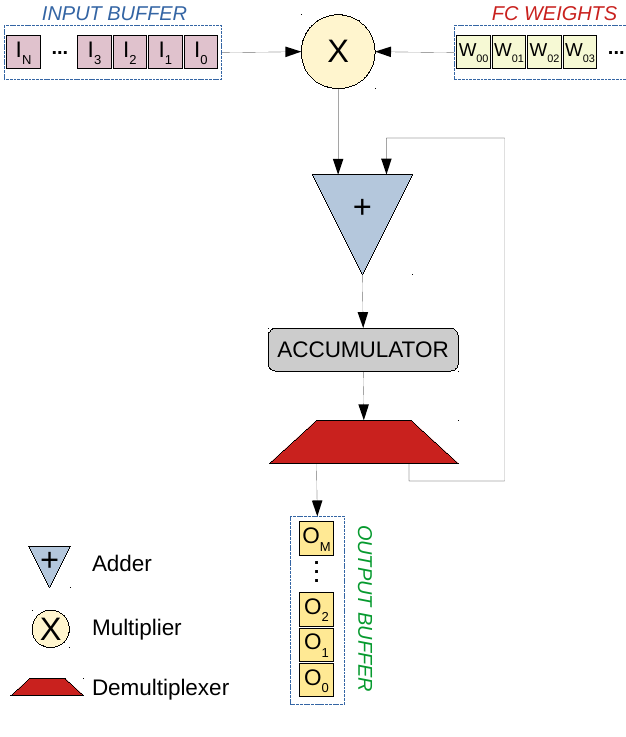
Figure 6. Fully connected layer streaming architecture. In this architecture, the input values are streamed in, and the corresponding weights are fetched from the local BRAM memories for the MAC operation that takes place in the multiplier and the adder. The result is accumulated with the help of the accumulator and the demultiplexer. Once the MAC operations are done, the demultiplexer pushes the result value to the output streaming